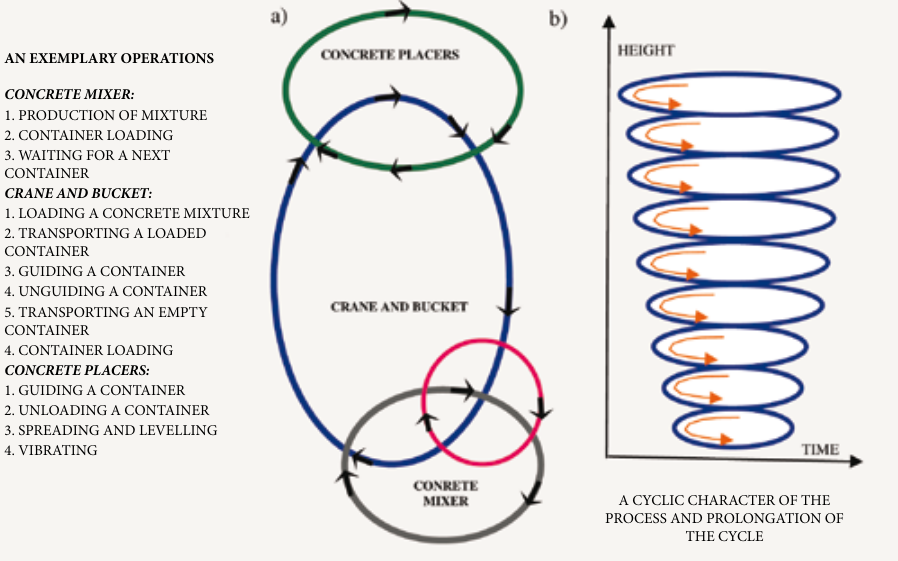
Fig. 3. A submodel of the construction